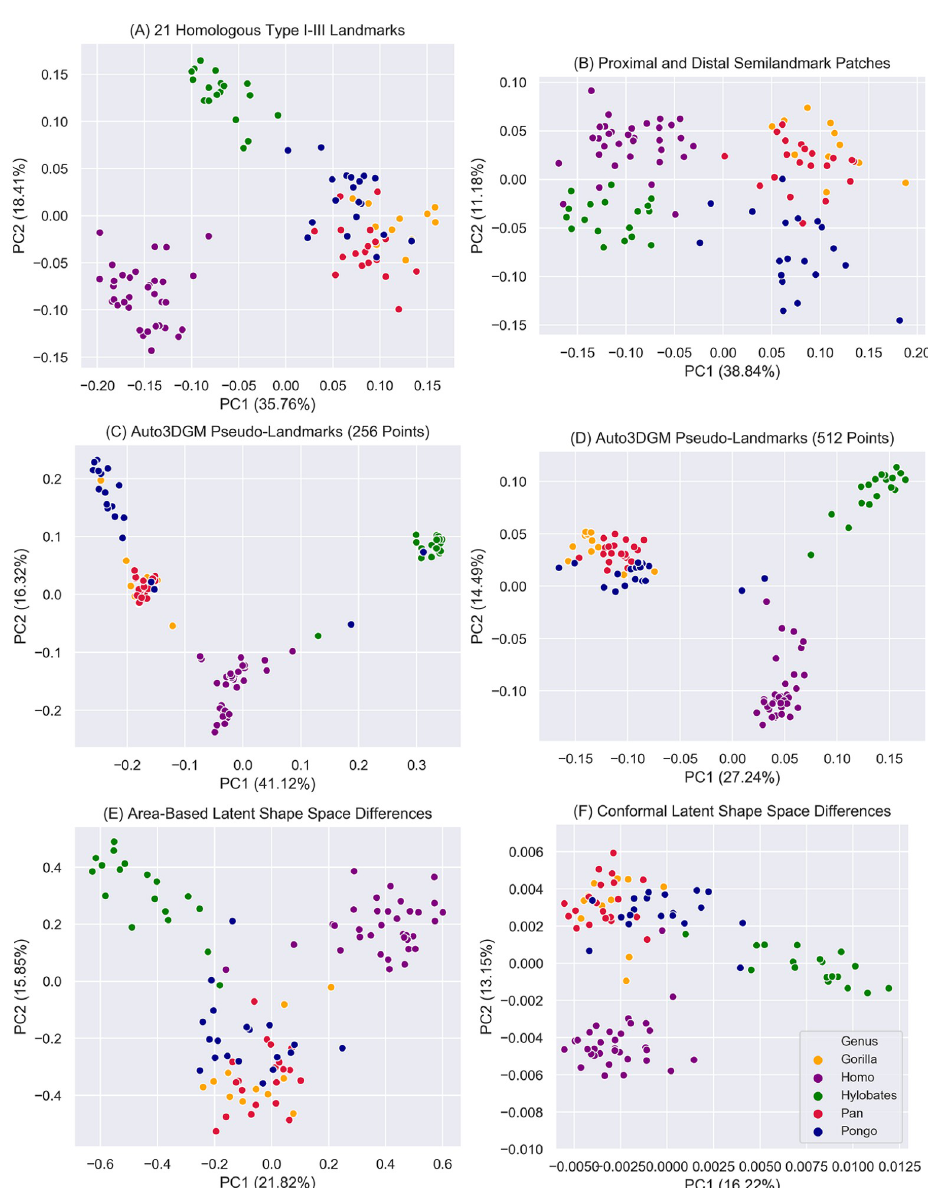
Fig 6. Shape space differences between manually digitized and automated morphological quantification approaches. The principal component (PC) scores PC1 and PC2 plotted in A and B are from the Procrustes aligned coordinates of the manually digitized landmarks. C and D are based on Procrustes-aligned pseudolandmarks obtained from auto3DGM analyses with 256 and 512 points, respectively. E and F are PCs obtained from our LSSD characterization. E is a morphospace derived from area-based differences in hominoid cuboid shape, while F is based on conformal shape differences.